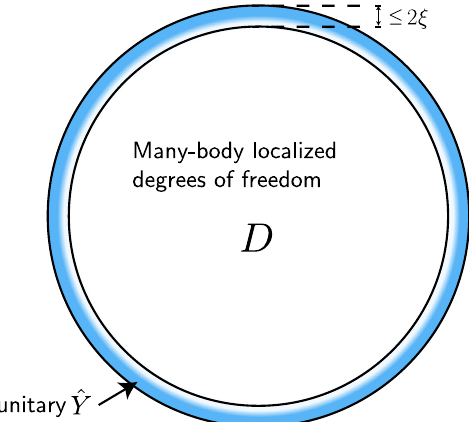
ˆ Y in a system